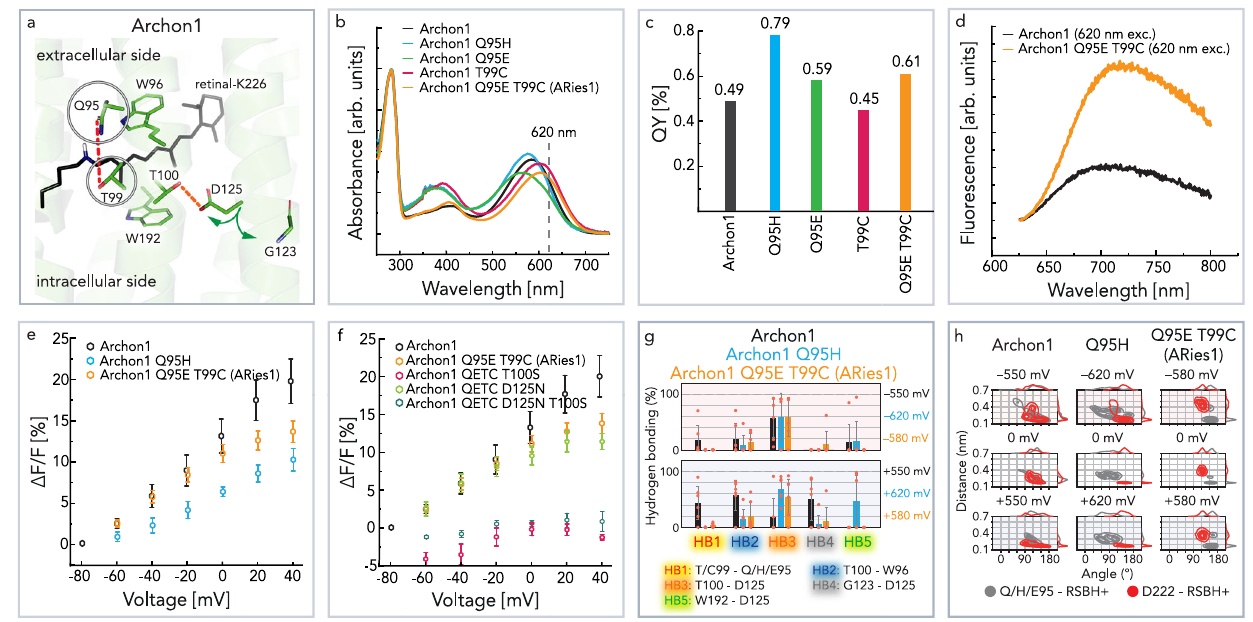
Fig. 6 | Mutant studies of fl uorescence increase. a Retinal binding pocket high- lighting mutated residues — Q95 and T99. b Absorption spectra of Archon1 and its D95X variants. c Fluorescence QY of Archon1 and its D95X variants. d Emission